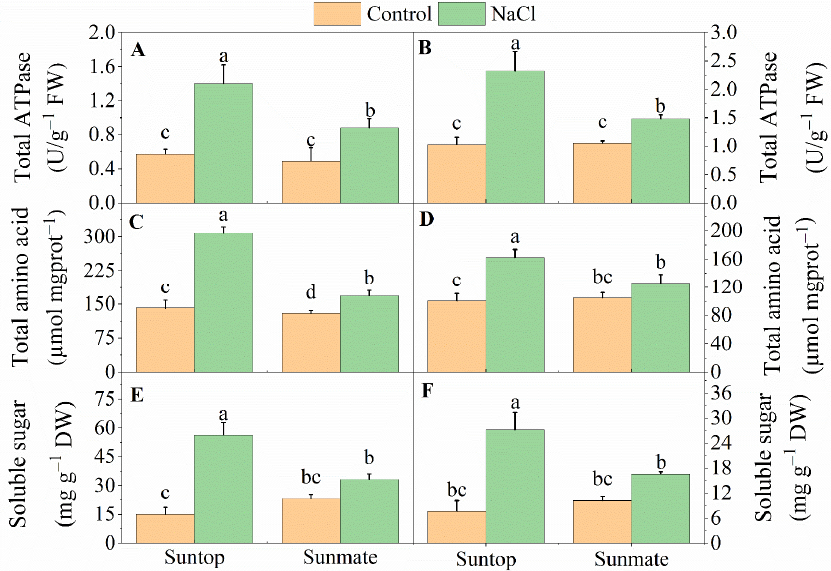
Figure 1. Total ATPase activity ( A , B ), contents of total amino acids ( C , D ) and soluble sugars ( E , F ) in leaves (left panel) and roots (right panel) of two wheat cultivars, Suntop and Sunmate, exposed to 100 mM NaCl for five days. These data are means ± SE ( n = 4). Different letters indicate significant differences at p -values = 0.05.